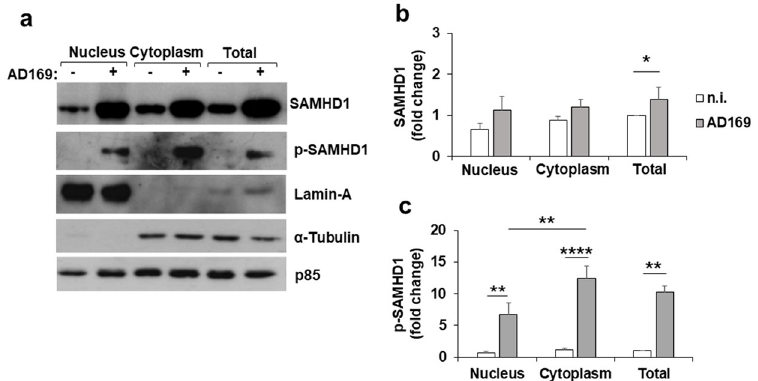
Fig 8. pT592-SAMHD1 is largely localized in the cytoplasm upon HCMV infection. a) HFFs were infected with HCMV at an MOI of 1 and nuclear, cytoplasmic, and total cell extracts were prepared at 3 dpi. Thirty μ g of proteins were loaded and subjected to immunoblotting with the indicated antibodies. Lamin-A and α -tubulin were used to confirm fractionation efficiency, and p85 as loading control. Results derive from one representative experiment out of four. b-c) The relative amount of total (b) or pT592-SAMHD1 (c), normalized to that of p85, was determined by densitometric analysis and is relative to that of total cell extracts in n.i. cells, which was arbitrarily set as 1. Data are expressed as mean ± SE of four independent experiments. � , p < 0.05; �� , p < 0.01; ��� , p < 0.001; ���� , p < 0.0001.